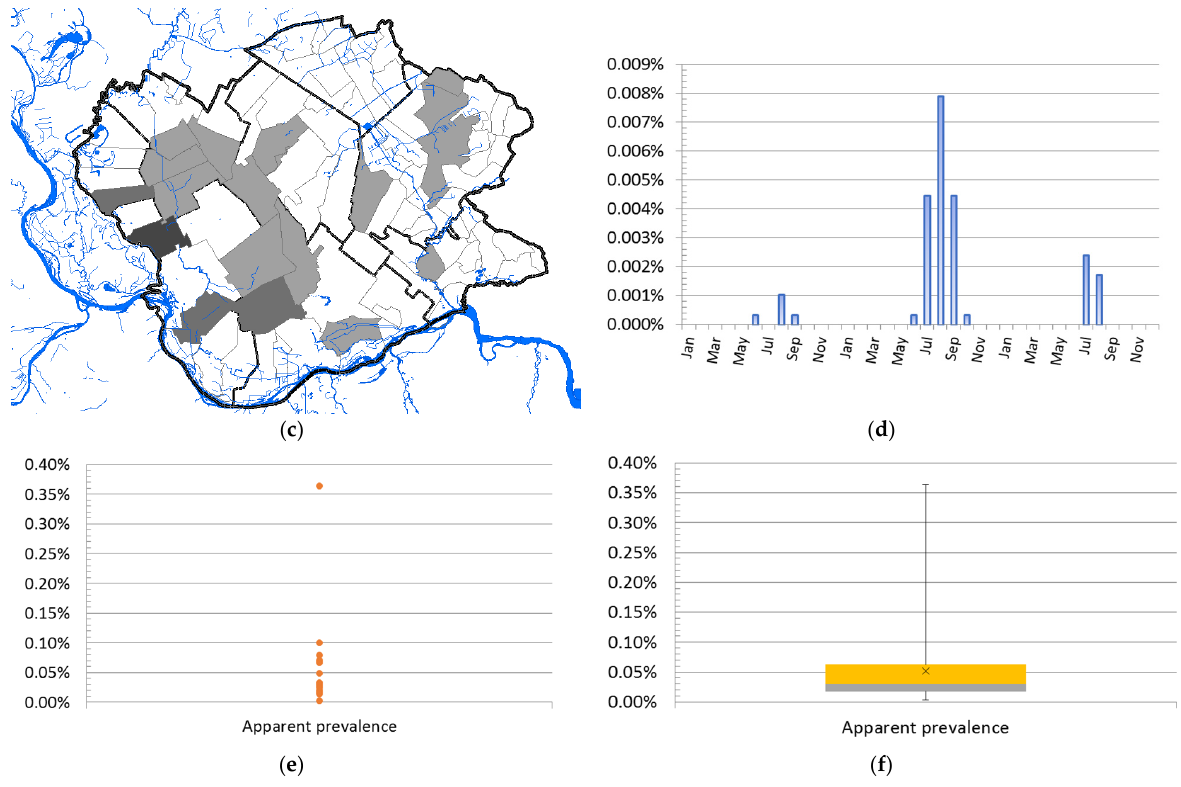
Figure 2. Epidemiological characteristics of West Nile virus outbreaks in 2017, 2018, and 2019: ( a ) Distribution of WNV human cases in 2017; ( b ) distribution of WNV human cases in 2018; ( c ) distribution of WNV human cases in 2019; ( d ) incidence risk of WNV infection in humans during the study period; ( e ) dot plot of WNV prevalence in 2018; ( f ) box plot of WNV prevalence in 2018.